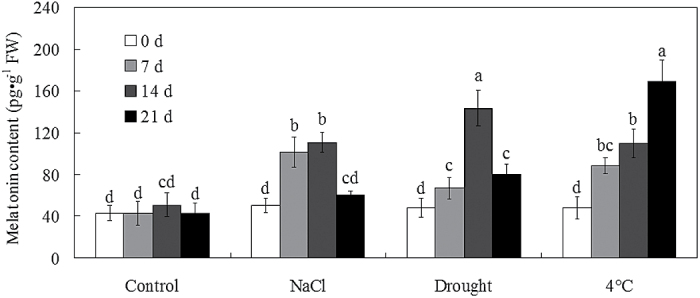
The endogenous melatonin level was induced by salt, drought, and cold stresses in bermudagrass. Twenty-eight-day-old bermudagrass plants were treated with control, 300mM NaCl, drought, and cold (4 °C) stresses for 0, 7, 14, and 21 d, respectively. Bars with different letters above the columns of figures indicate significant differences at P<0.05 (Duncan’s range test).